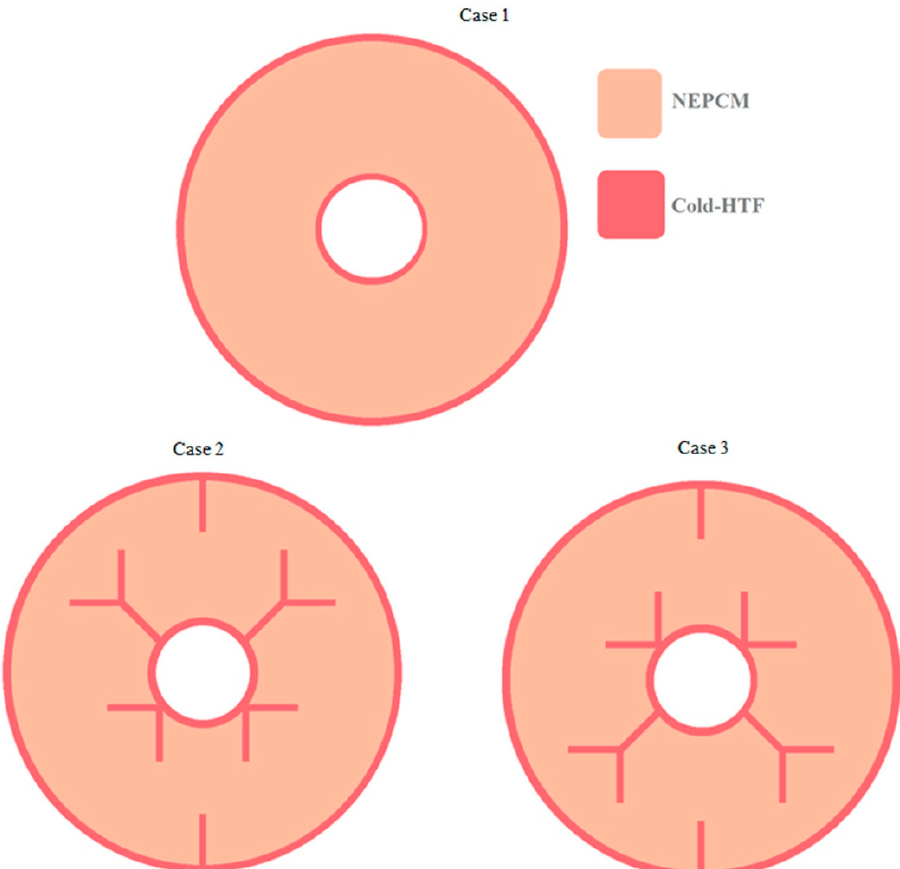
Figure 10. Fin configurations for the three cases studied by Hajizadeh et al. (Copyright 2020 Elsevier) [75].